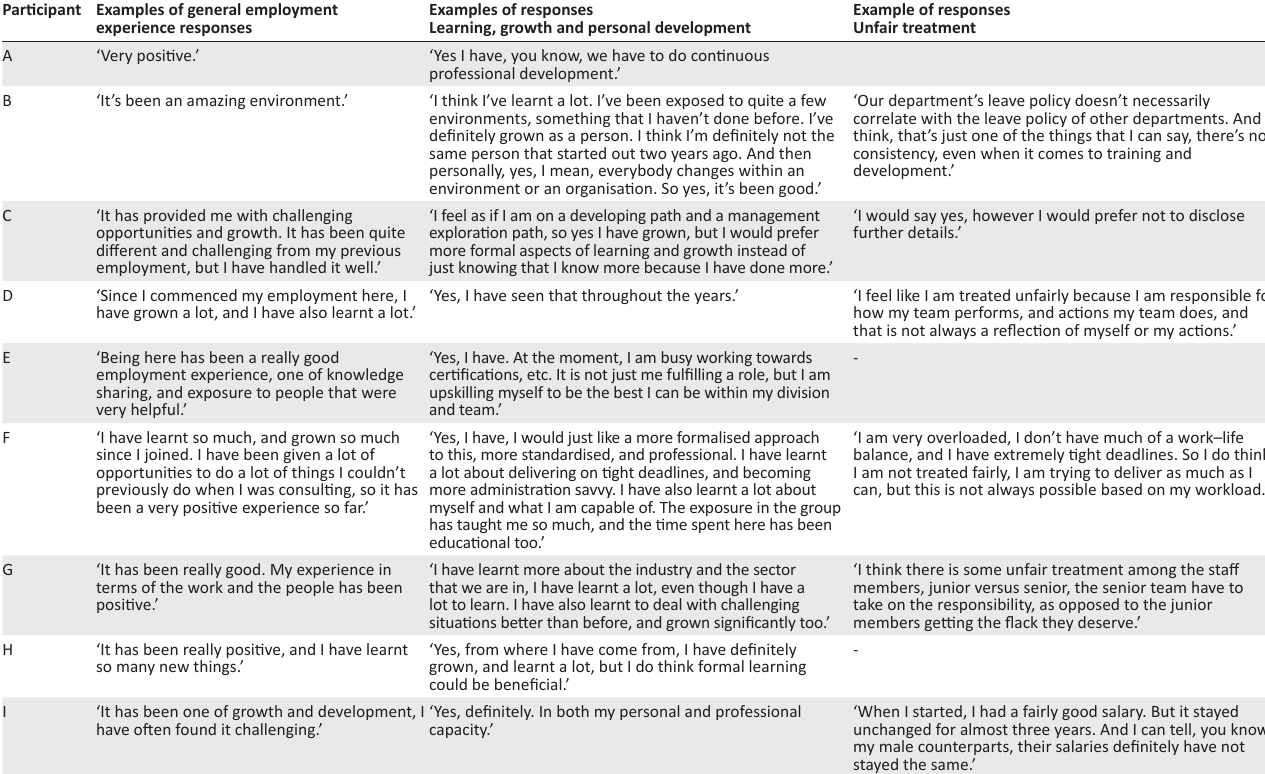
TABLE 2: Employment experiences. Participant Examples of general employment experience responses